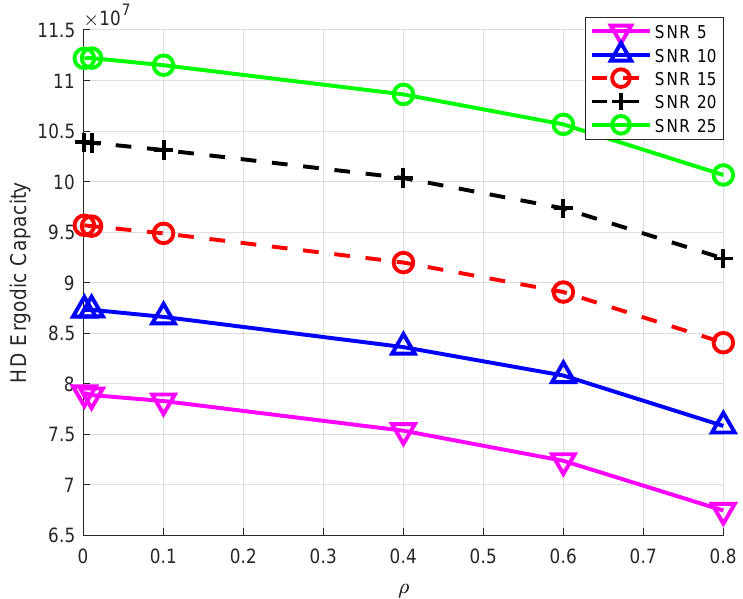
Figure 5. Capacity comparison of half-duplex with different